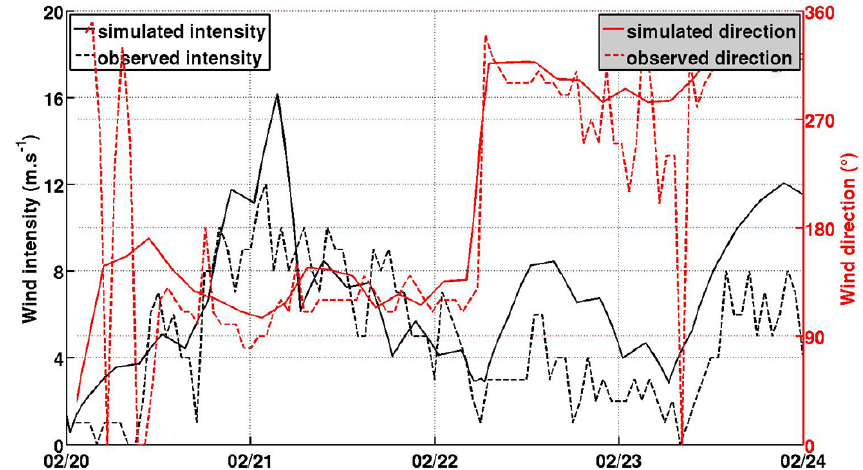
Fig. 9. Simulated (solid line) and observed (dashed line) wind intensity (black) and direction (red). The data are provided by the Toreilles station and simulated wind is given at the SODAT